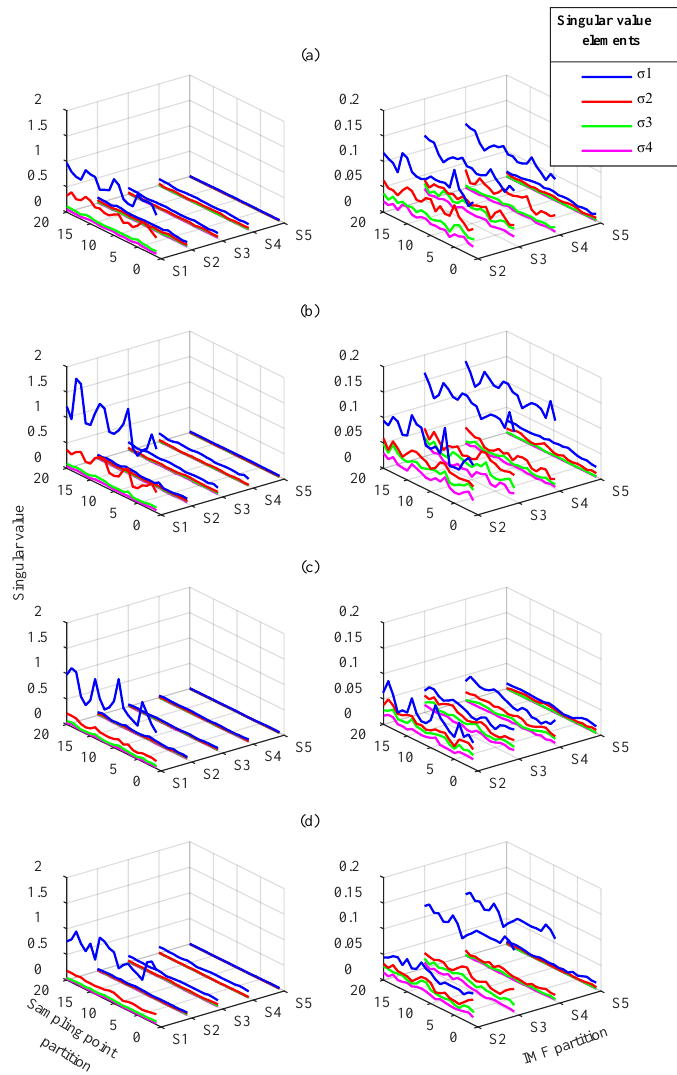
Figure 10. Singular value vector matrices from EEMD: ( a ) normal gear, ( b ) gear with wear, ( c ) gear with breakage, and ( d ) gear with root crack tooth.